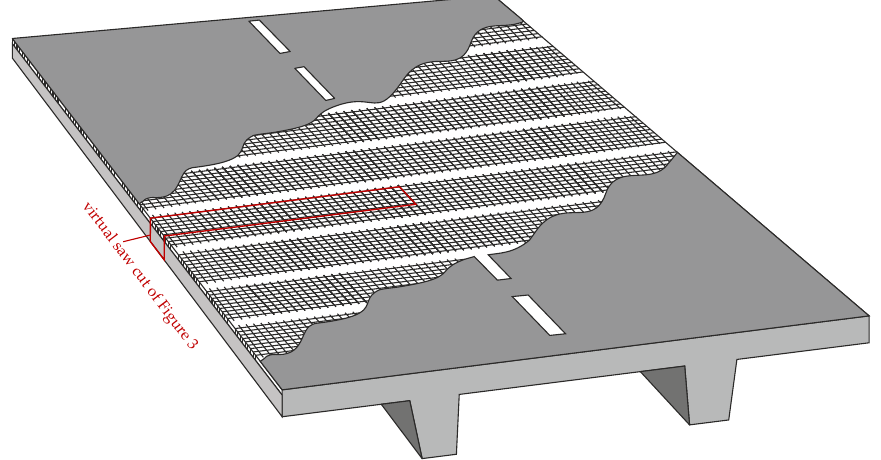
Figure 2. Position of the additional textiles on an exemplary bridge deck